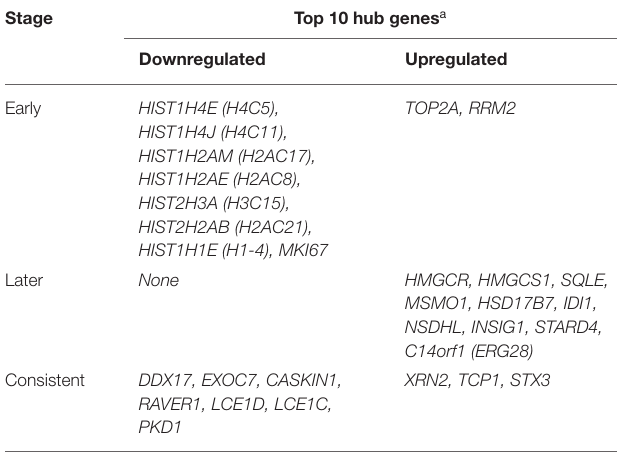
TABLE 1 | Early (5h), later (24h) and consistent top 10 hub